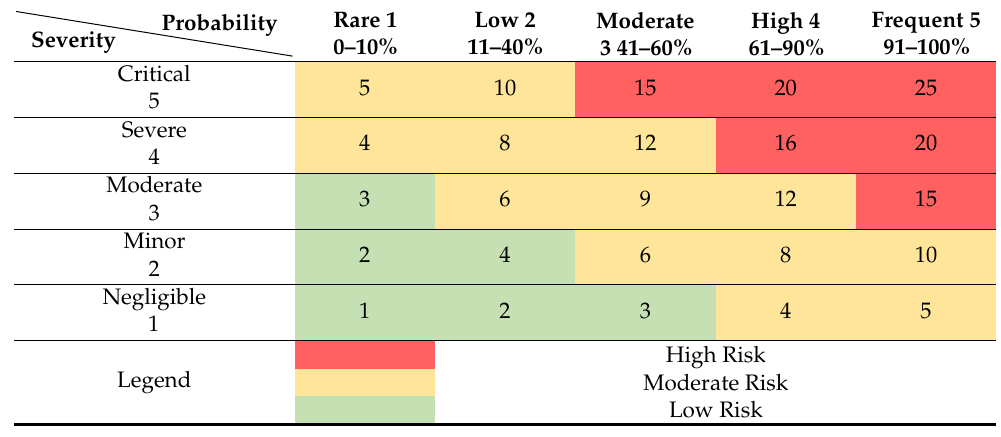
Table 2. Grading scale of safety risks of educational buildings